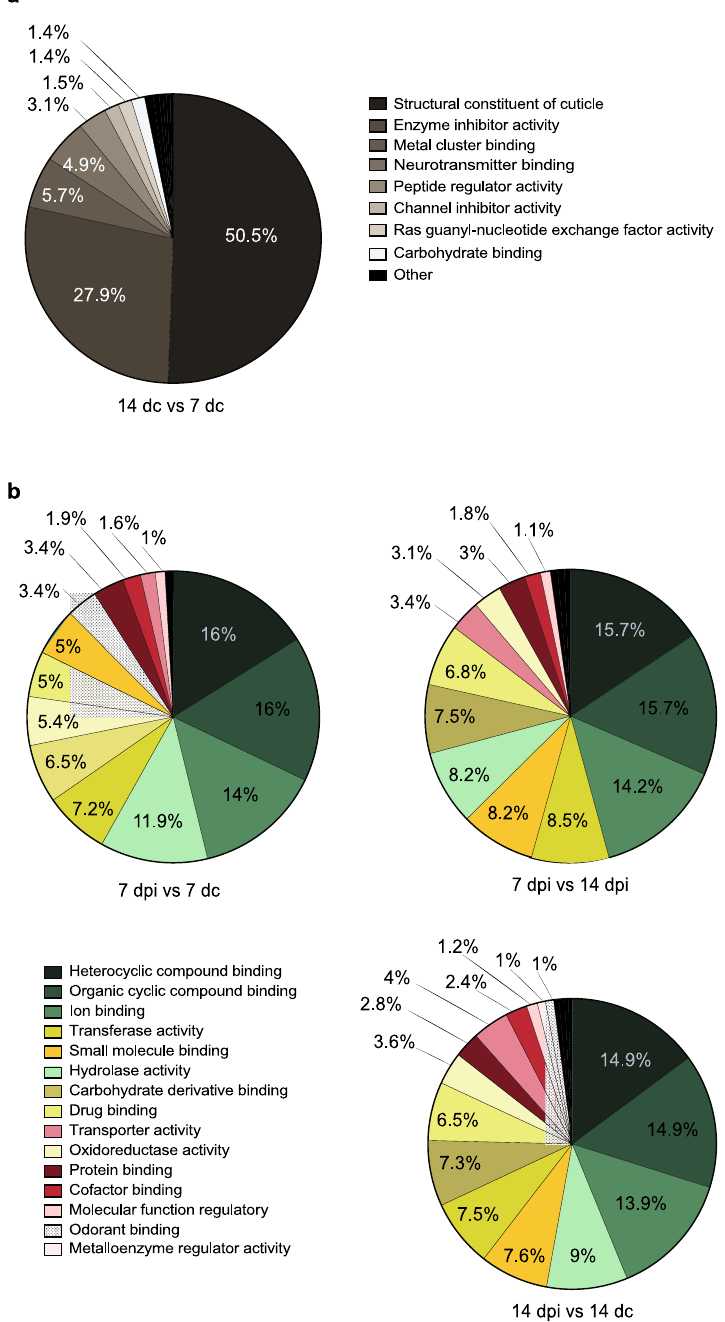
Figure 3. Plasmodium falciparum infection stage affects the functional ontology of differentially abundant antennal transcripts. A level 3 gene ontology analysis of molecular function of Anopheles gambiae antennal transcriptomes comparing those of 13 and 19 days post-emergence females (7 days control, dc and 14 dc, respectively) ( a ), as well as those of 7 and 14 days post-infection (dpi) females along with age-matched controls ( b ). Gene ontology classes that were included comprised greater than 1% of the total number of differentially abundant genes identified. Those with less than 1% are grouped together in